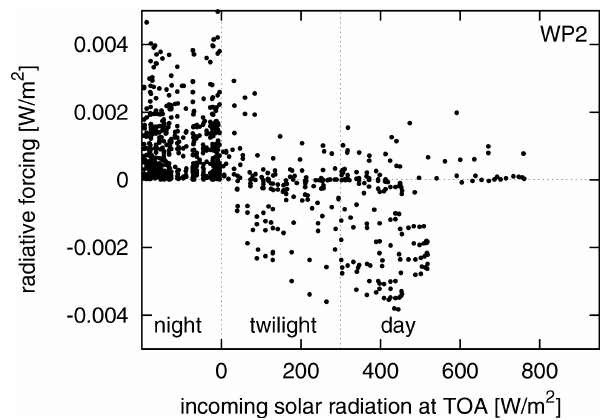
Figure 6. Instantaneous net radiative forcing at top of atmosphere (TOA) of individual contrails relative to the actual, local time (night, daytime, twilight) for weather pattern